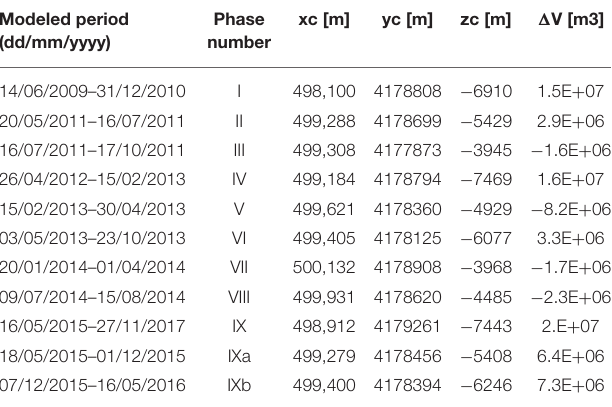
TABLE 2 | Final optimal solutions for each modeled